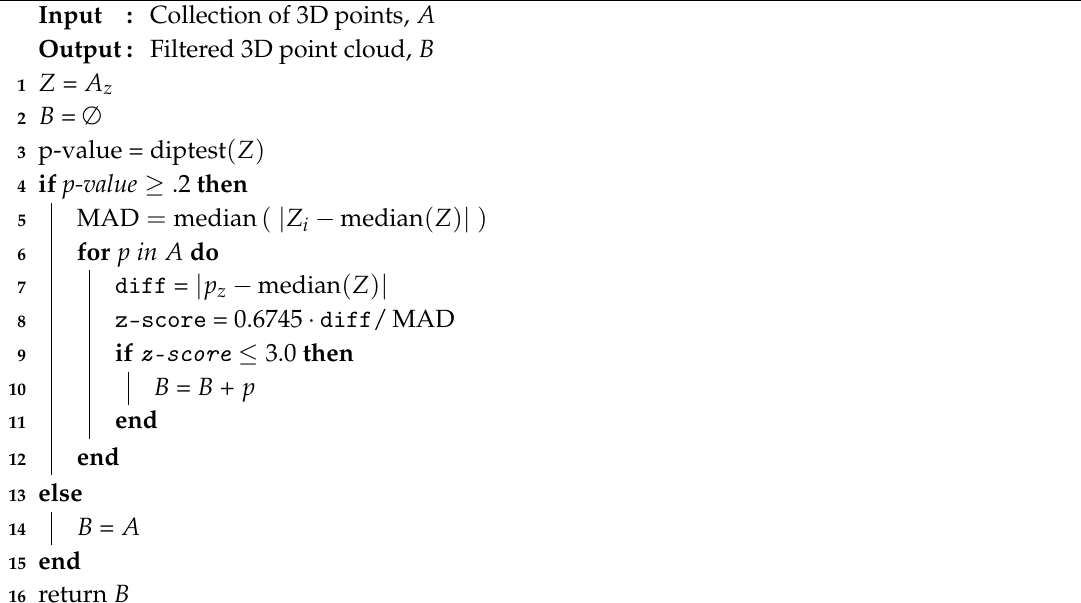
Algorithm 1: Filtering of 3D LiDAR point cloud using Medium Absolute